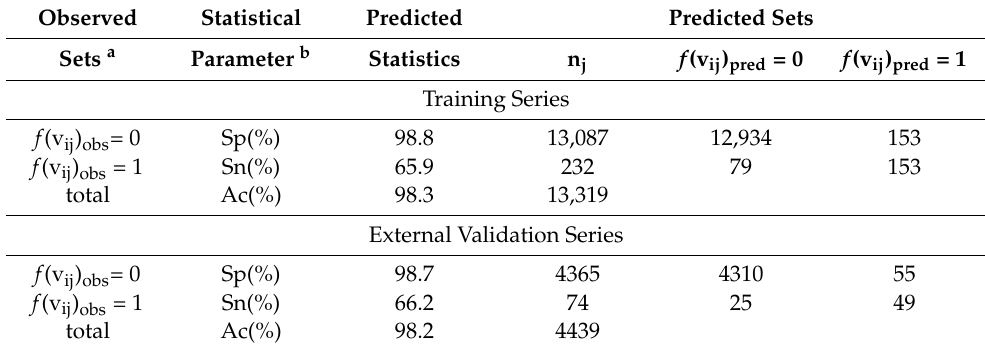
Table 1. IFPTML-GDA model result.